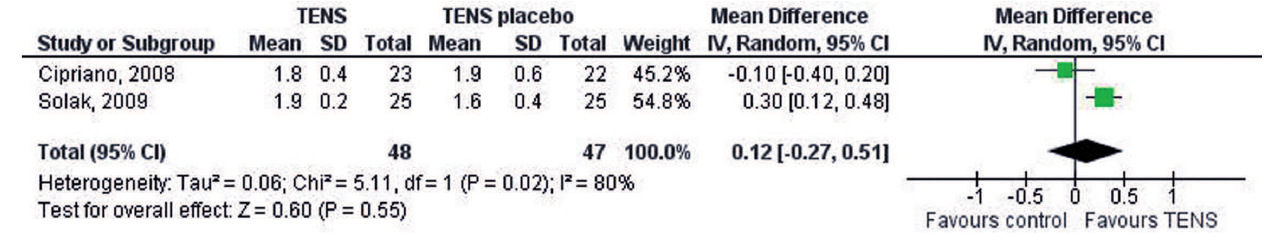
Fig. 5 – Análise da capacidade vital forçada referente aos estudos que realizaram cirurgia com abordagem por esternotomia mediana: comparação da TENS vs. TENS placebo. TENS = estimulação elétrica nervosa transcutânea